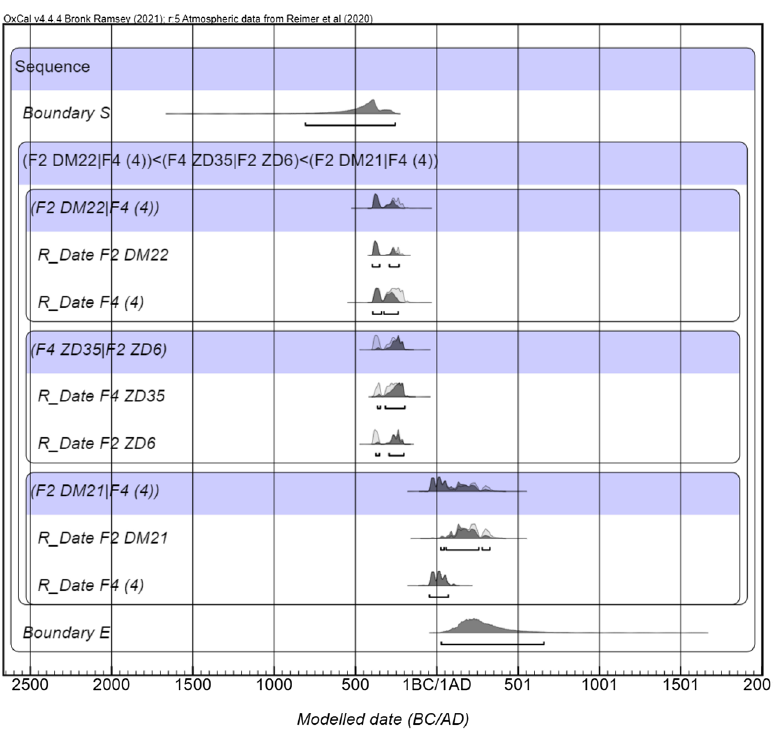
Figure 7. Calibrated radiocarbon dates for Shirenzigou for F2 and F4. Accelerator Mass Spectrometry Dating Laboratory of Peking University and calibrated using OxCal and IntCal20 51,52